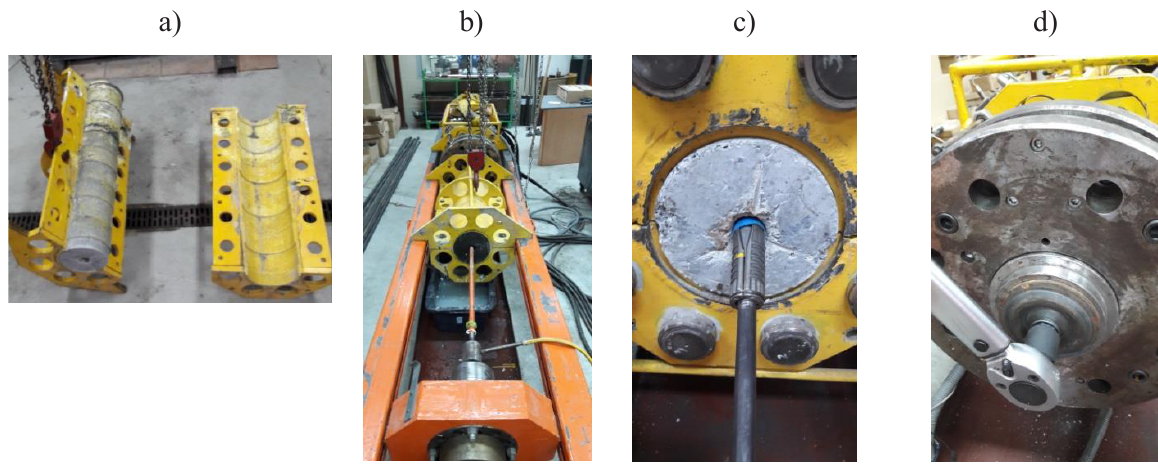
Fig. 5. Test stand setup; a) split cylinder filled with concrete mix; b) concrete block drilling; c) inserting